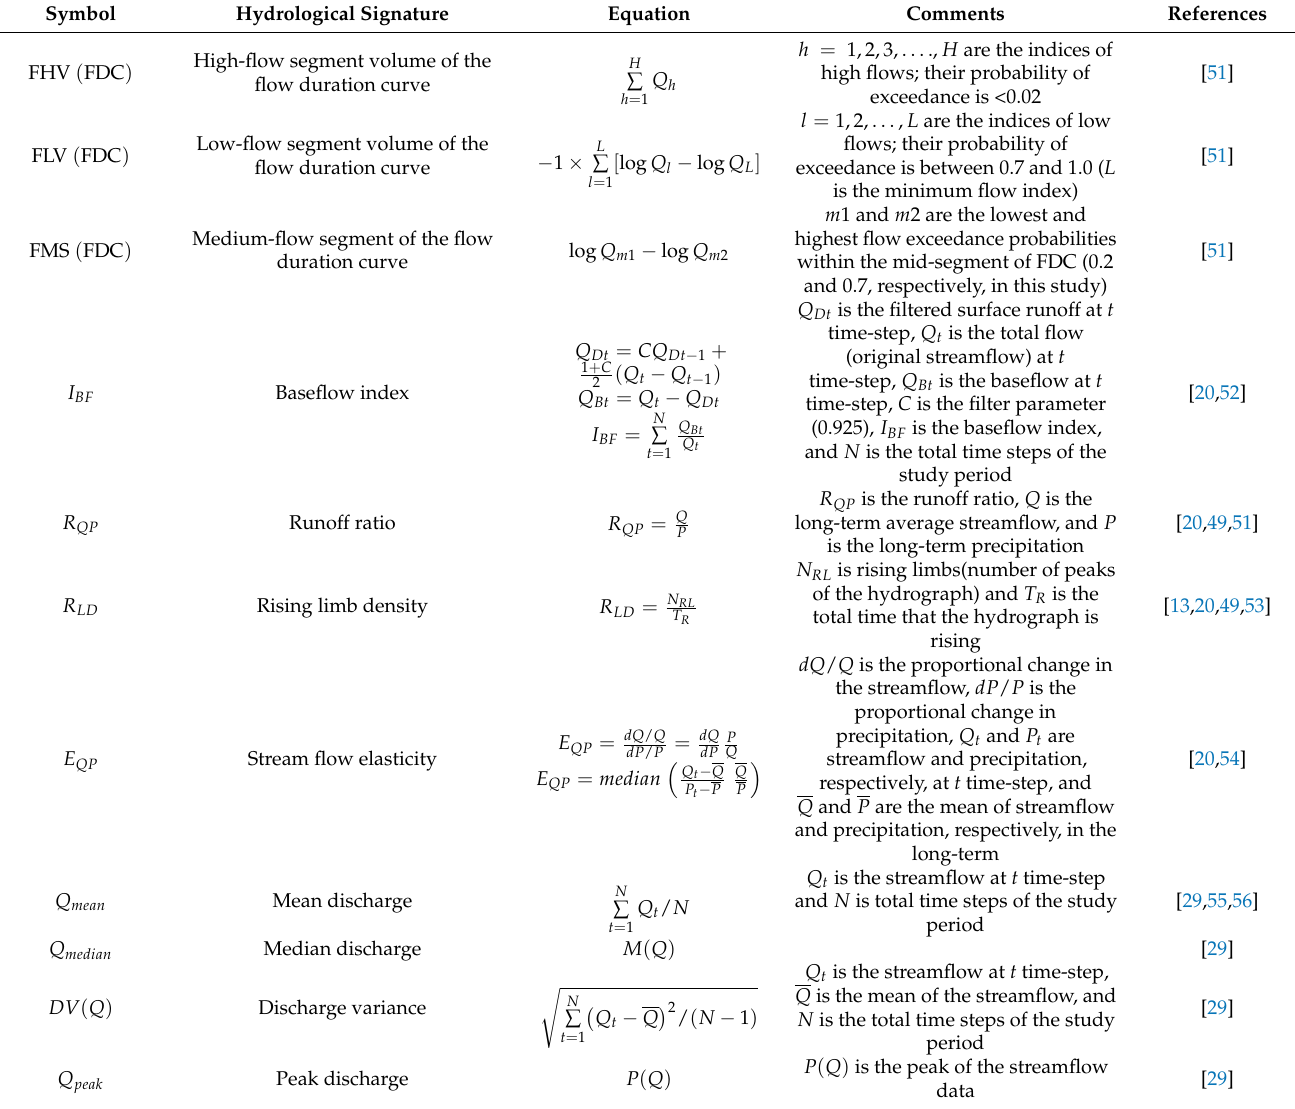
Table 1. Summary of hydrological and statistical signatures used in the